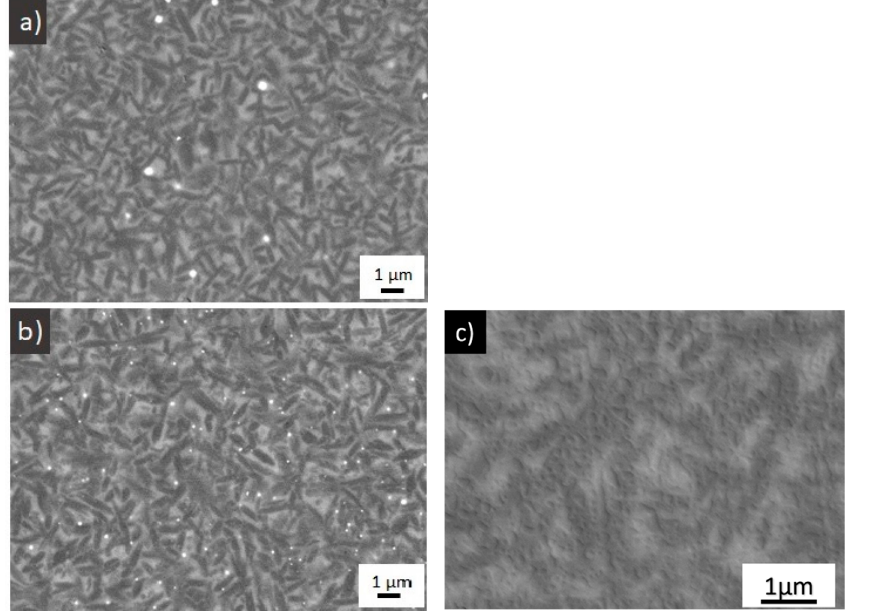
Figure 2. SEM micrographs of ( a ) material A ( b ) material B and ( c ) material B—higher magnification. Table 4. Estimated chemical composition of glass phase in tested materials. wt.% of Oxides